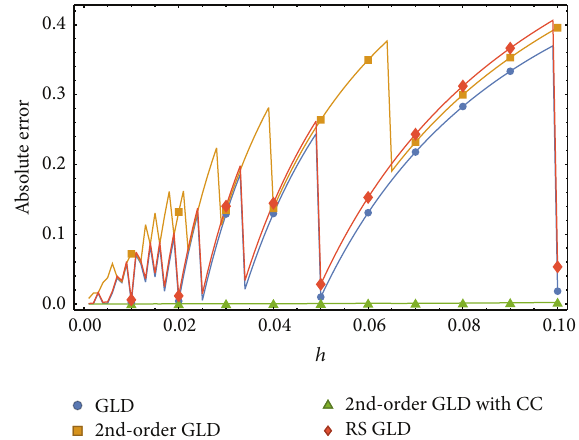
Figure 7: Absolute error for increasing 𝑁 for four different meth- ods.